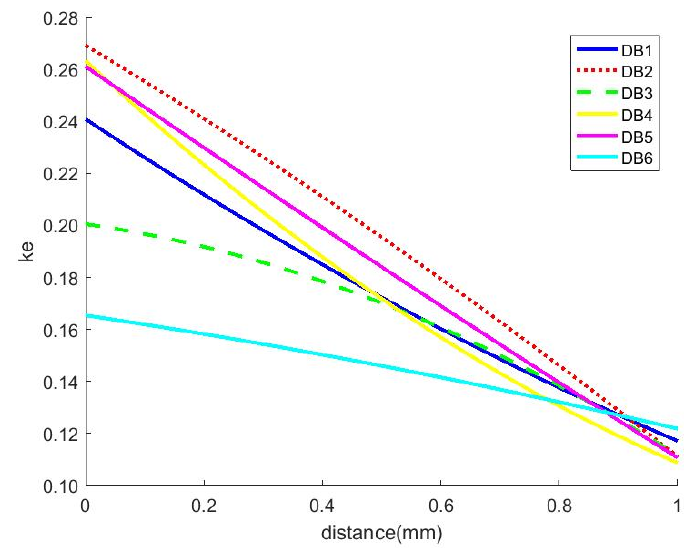
Figure 18. k e curve of six datasets. 𝜌𝜌 𝑒𝑒 speckle decorrelation coefficient of two frames of B-scans.